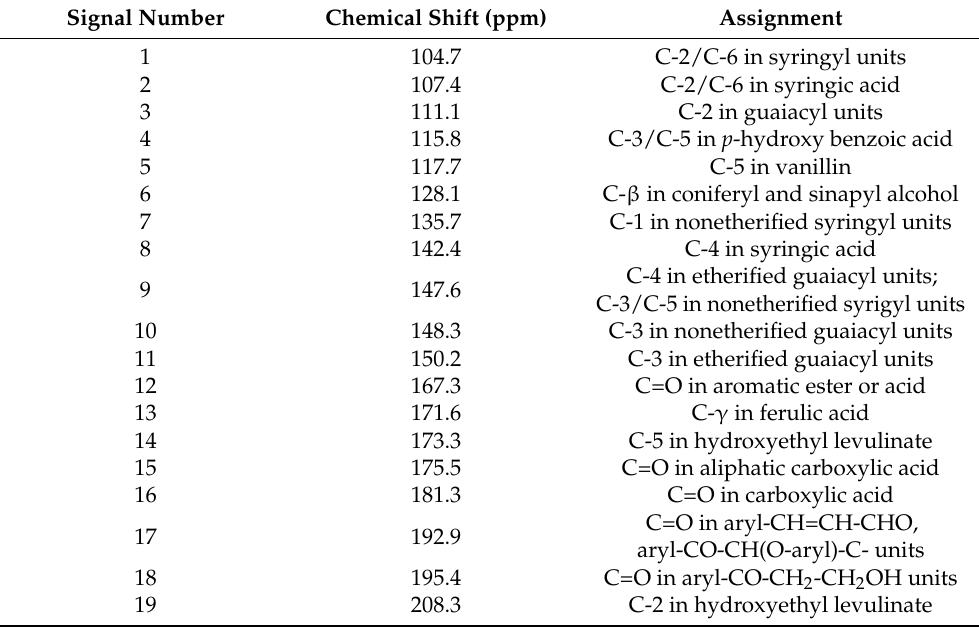
Table 5. Assignments of 13 C NMR signals in the region from 104.0 to 210.0 ppm for the CL LGS -5 and CL LGS -240 samples. Solvent: DMSO- d 6